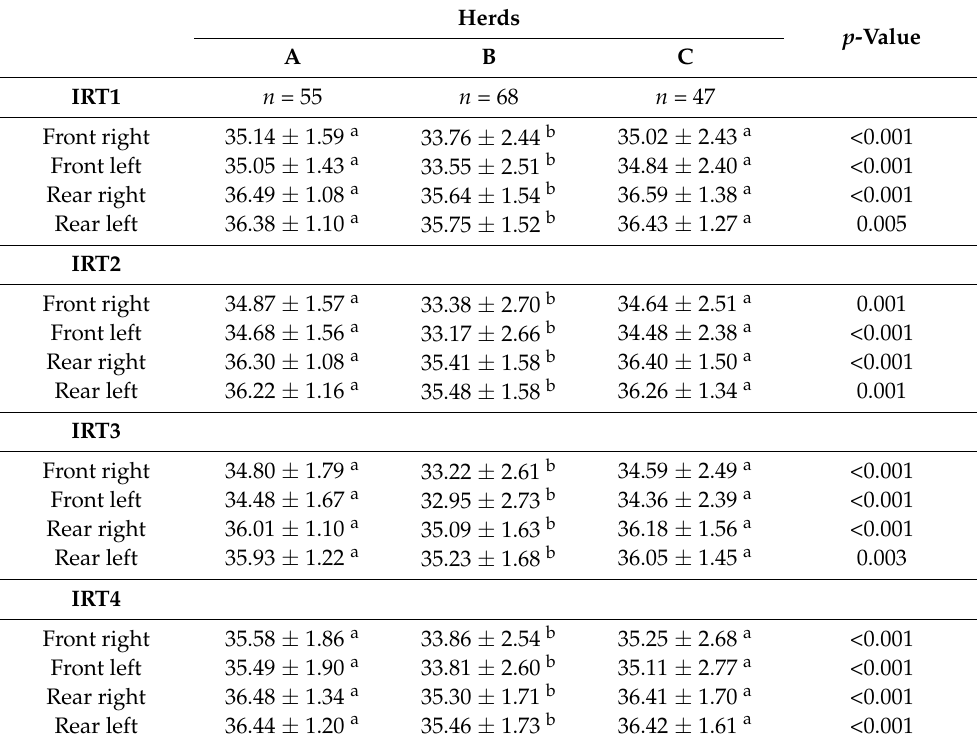
Table 3. Results of maximum temperature (mean ± SD) in each foot at four areas in replacement gilts of different genetic lines in three farrow-to-finish herds in Greece at second farrowing.